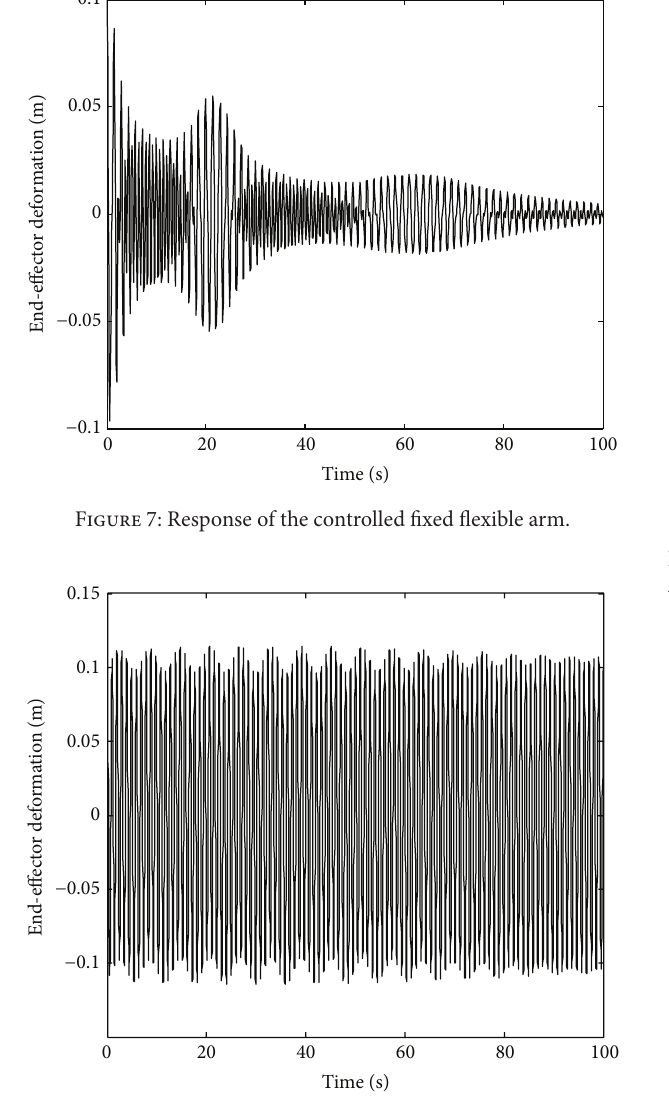
(24)–(28) are integrated numerically in the absence of damping. The relationship between the modal amplitudes 𝑎 1 (dashed line) and 𝑎 2 (solid line) is shown in Figure 10. It